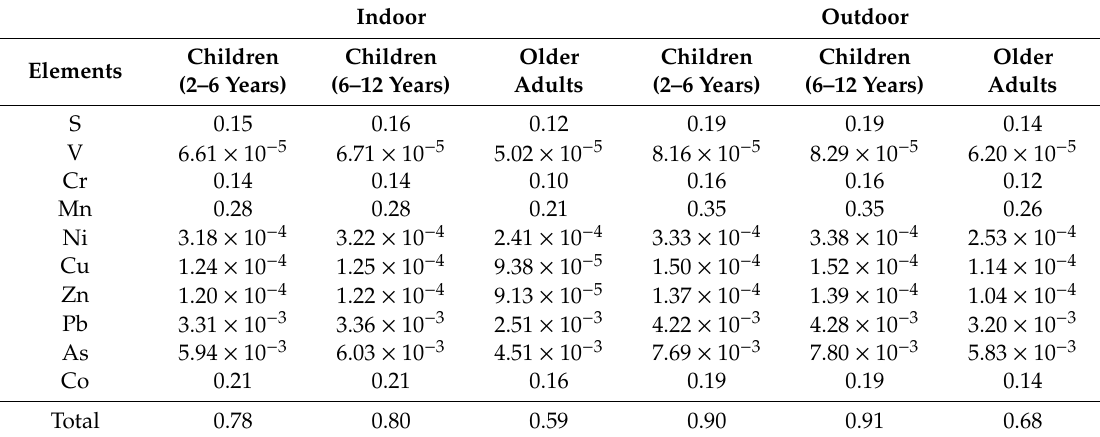
Table 2. R values estimated from elements of PM 2.5 in the indoor and outdoor